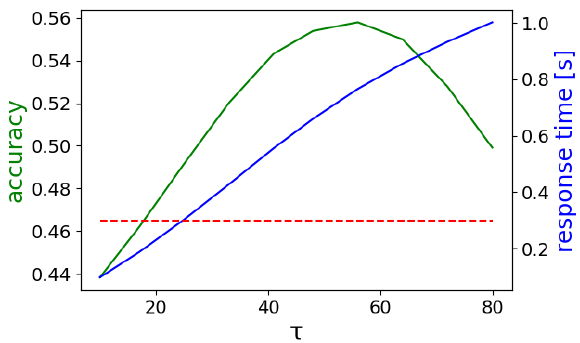
Figure 11. Classification accuracy (green) and response time (blue) when w = 1.6 s and τ is varied for the Att300 model. The red dashed line corresponds to 0.3